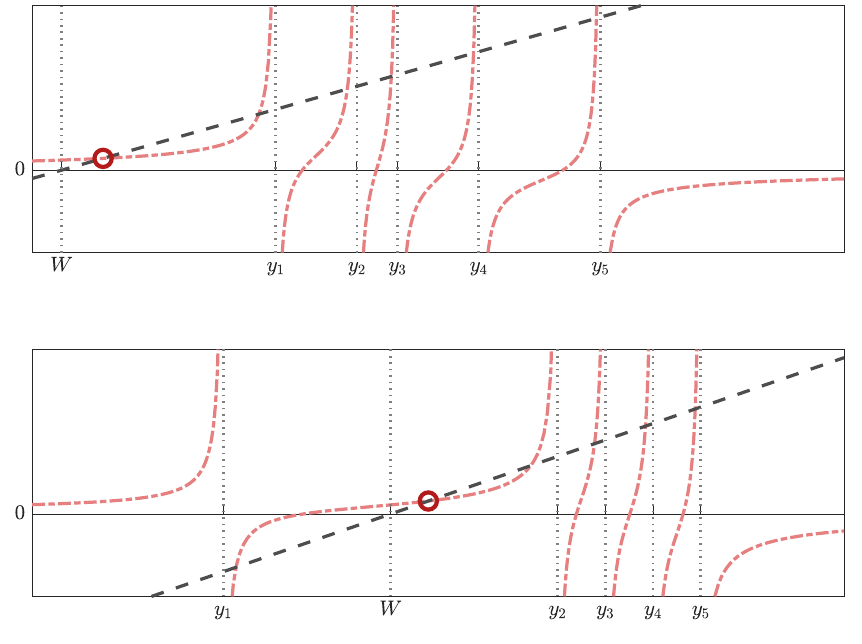
Figure 3. Illustration of two exemplary cases of the solution of (35). Whereas the dash-dot red styled lines indicate the right hand side of the function, the black colored dashed line depicts the left hand side of (35). A dark red circle symbolises the desired solution out of